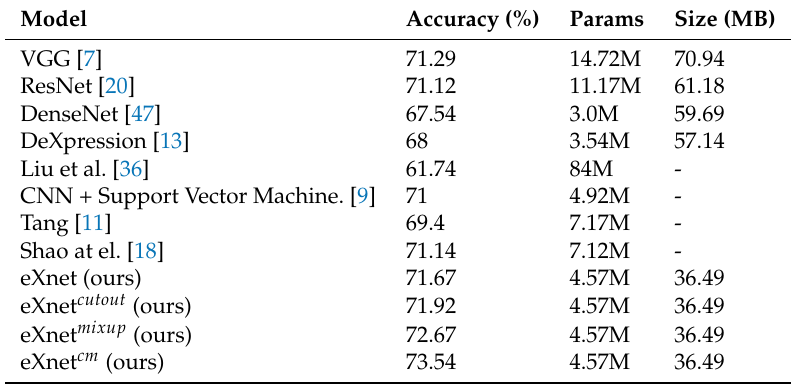
Table 4. Comparison of eXnet with benchmark networks on the FER-2013 dataset.